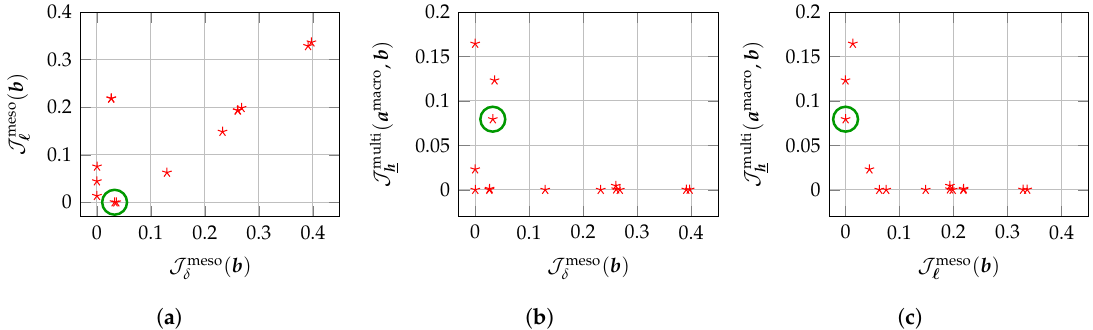
Figure 5. Different 2D cross-sections of the Pareto front with the noninferior (Pareto optimal) solutions represented by red stars (cid:63) and the best compromise optimal solution surrounded by a green circle # for ( b ) , J meso the mesoscopic domain of observation Ω meso . ( a ) cross-section ( J meso exp,1 δ